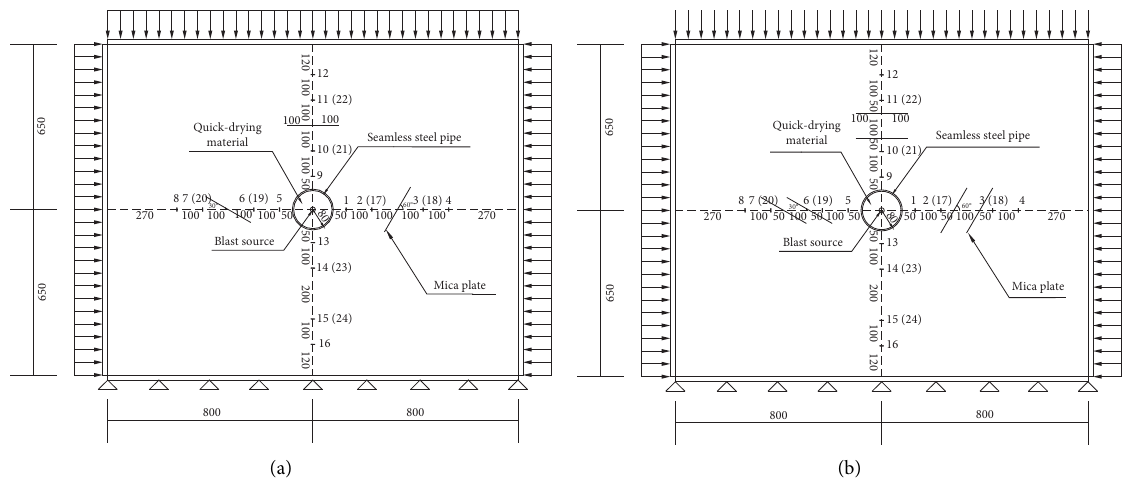
Figure 11: Arrangement of measuring points (unit: mm). (a) T1 sample. (b) T2 sample.